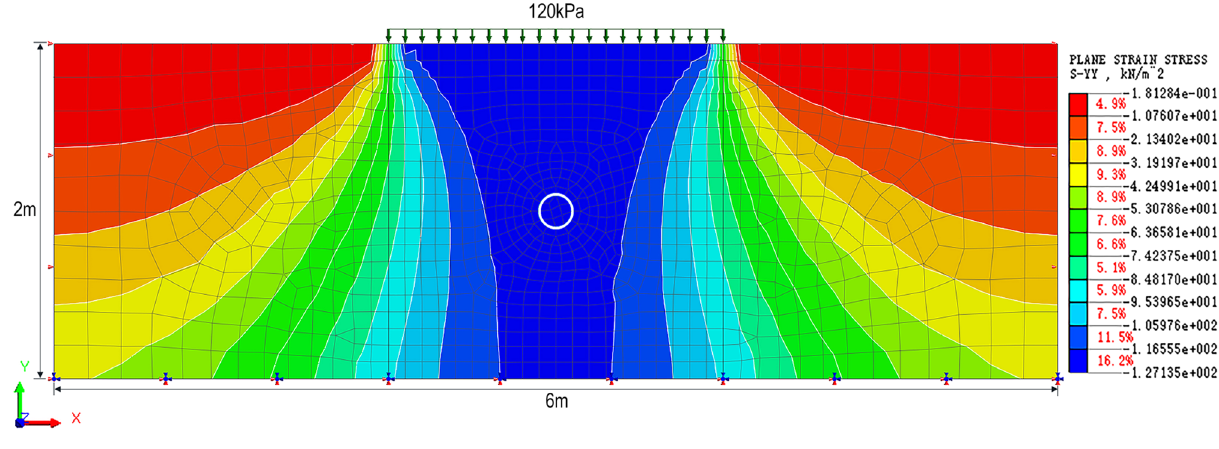
Fig. 2 Initial vertical stress field before